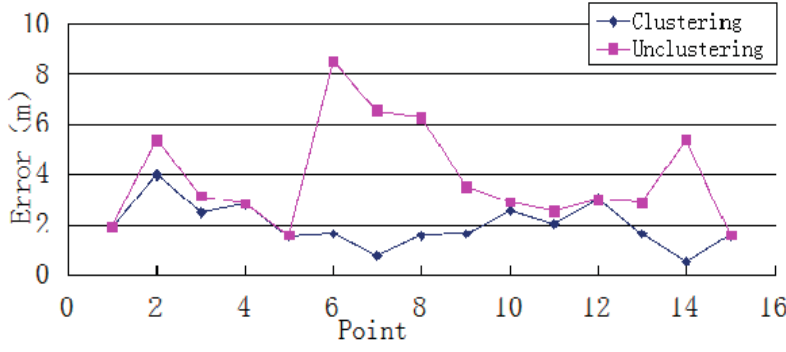
Figure 6. Single-point positioning maximum error.